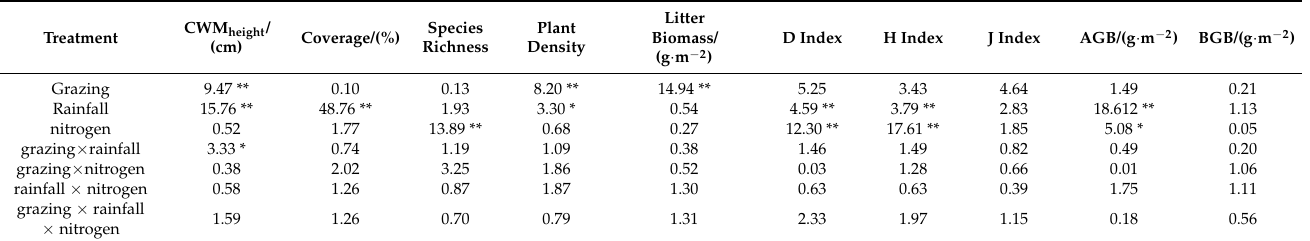
Table 2. Variance analysis of the response of vegetation characteristics to grazing, rainfall and nitrogen addition in the sandy grassland.